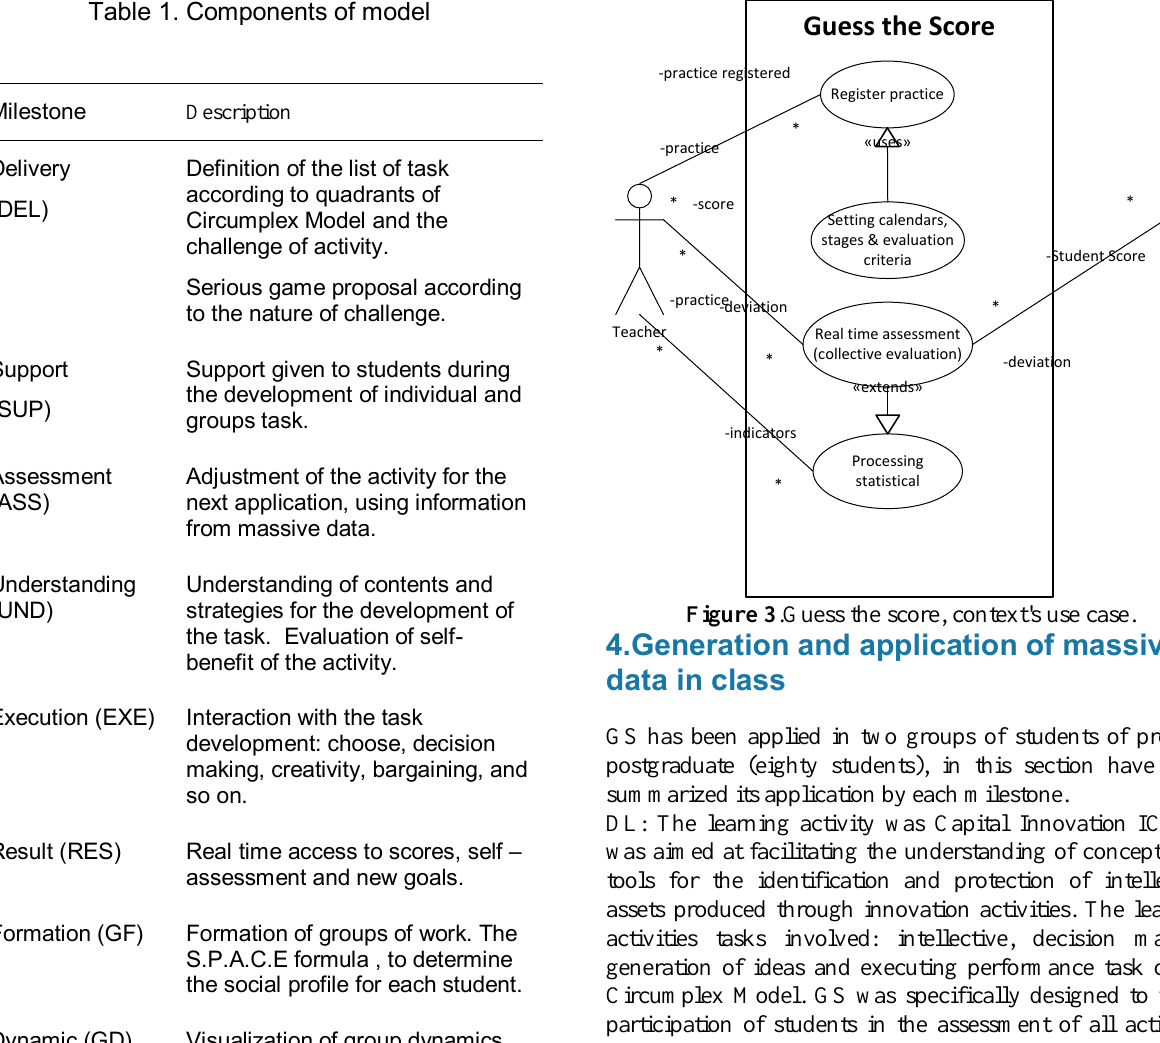
Table 1. Components of model